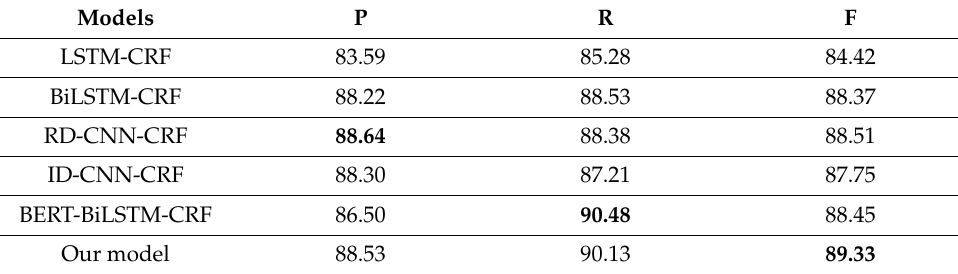
Table 4. Performance comparison results of each model.